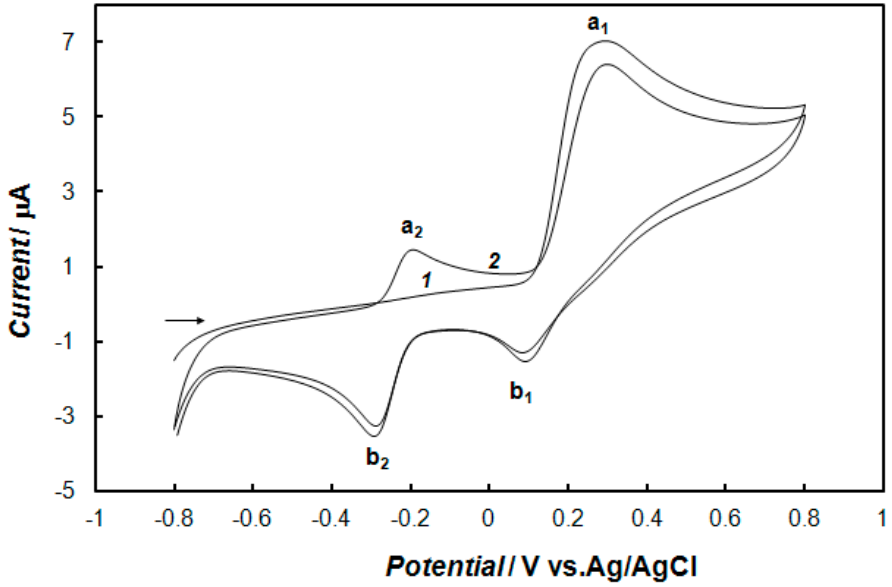
Figure 3. Cyclic voltammograms: ( 1 ) First and ( 2 ) second scans recorded onto the bare gold electrode in 0.1 M of phosphate buffer solution (pH 7.4) containing 1 mM of dopamine. The potential sweep rate was 0.1 V s − 1 .